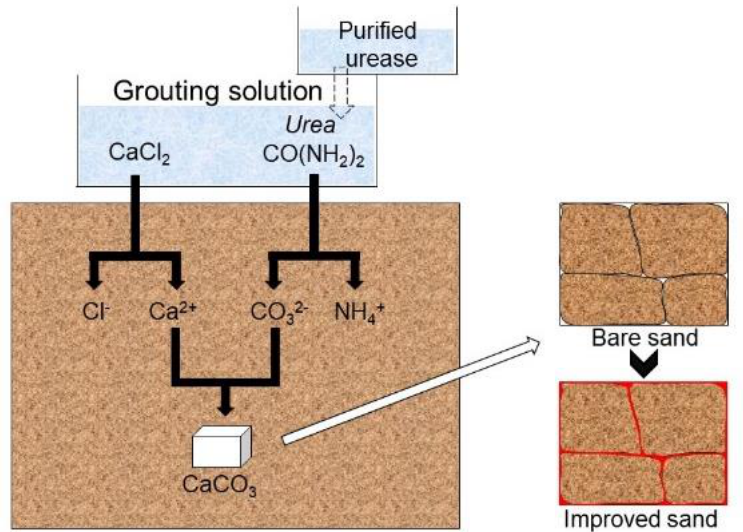
Figure 1. Schematic of precipitation process and grouting procedure in the enzyme-induced calcite precipitation (EICP) technique [19,21].